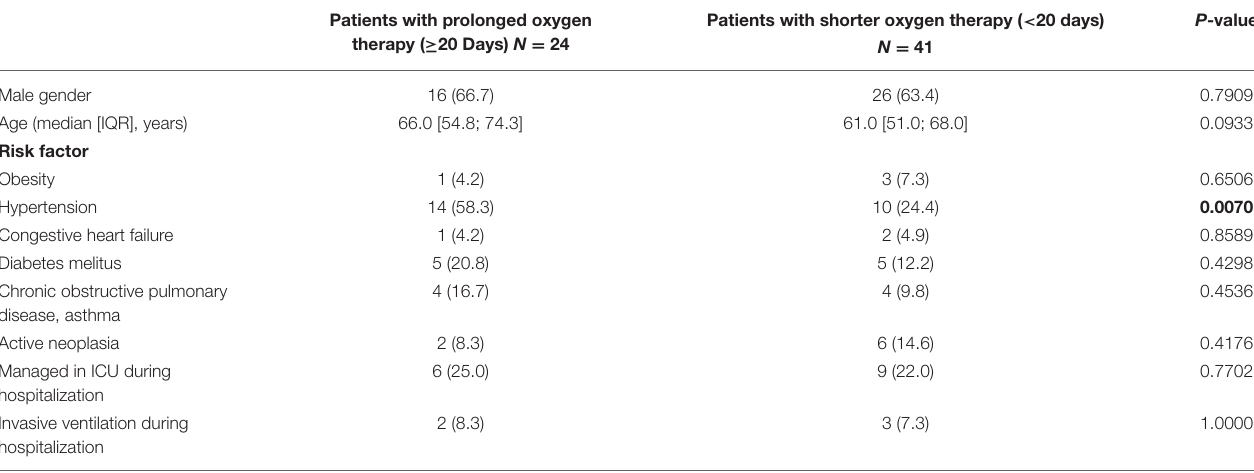
FIGURE 1 | Bar plot of alert on COVIDOM platform generated by patient with nasal oxygen. TABLE 2 | Univariate analysis of variables associated with longer duration of nasal oxygen therapy ( n =